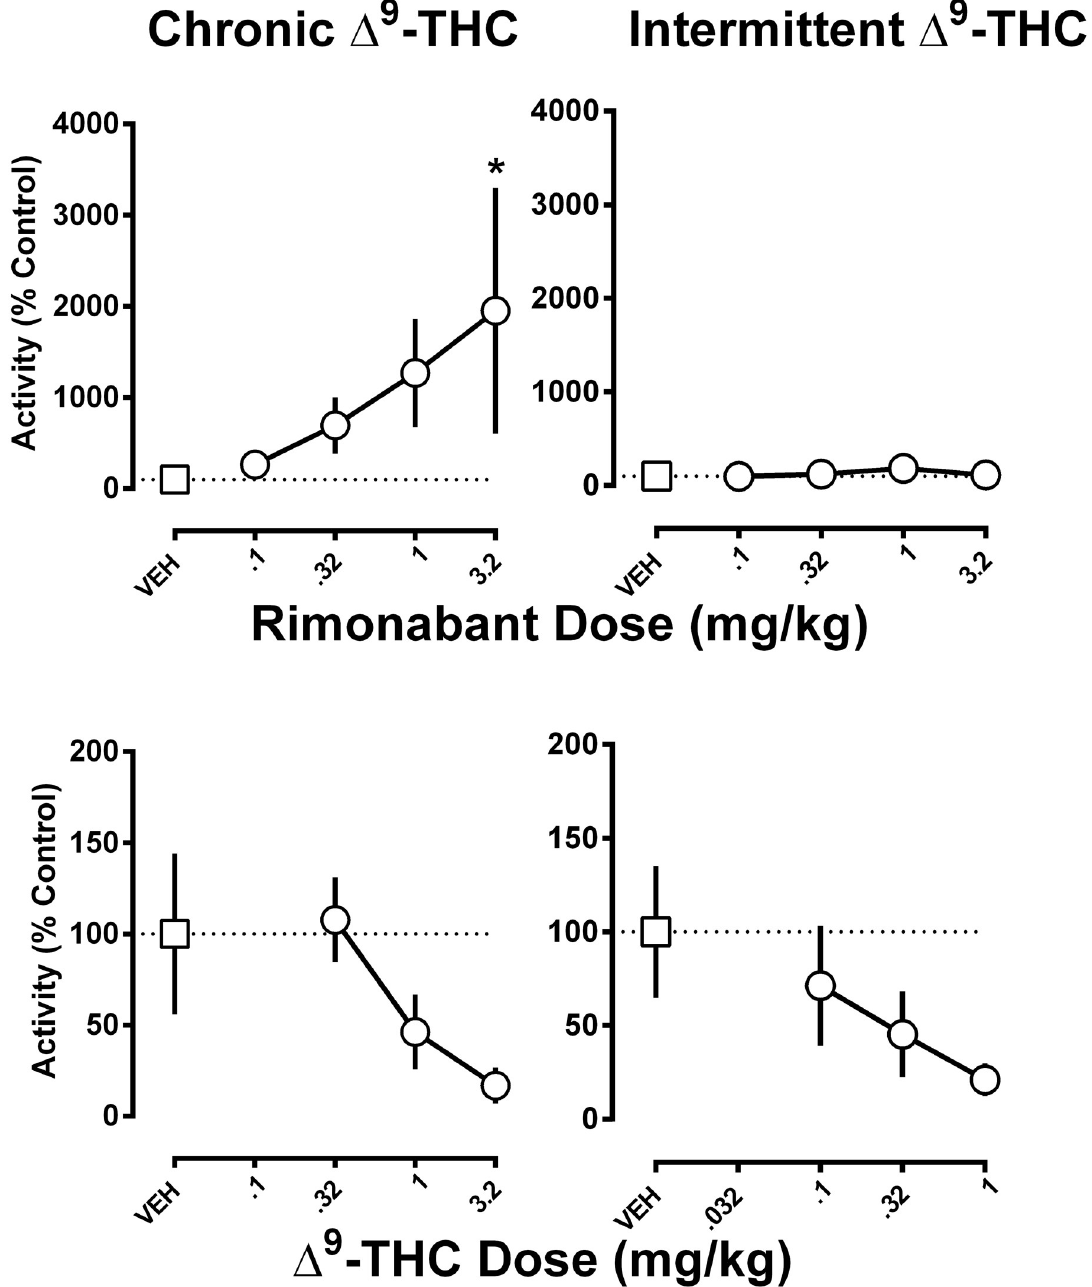
Fig 3. The effects of rimonabant and Δ 9 -THC in chronically and intermittently Δ 9 -THC-treated monkeys. The effects of rimonabant (top panels) and Δ 9 -THC (bottom panels) in monkeys receiving either chronic Δ 9 -THC (left panels) or intermittent Δ 9 -THC (right panels). Activity counts are expressed as a percentage of the control calculated from the average of two separate vehicle tests. The abscissae denote dose in milligram per kilogram of body weight. � P < 0.05 and vs. vehicle. Data reflect mean ± SEM, n = 5 monkeys/